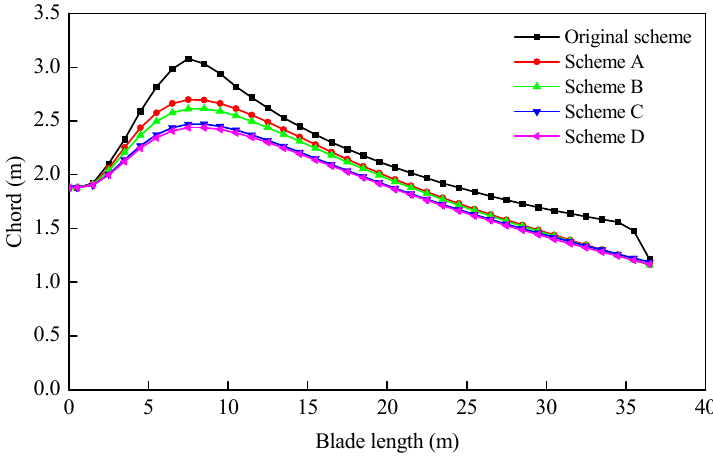
Figure 14. Comparison of chord distribution.